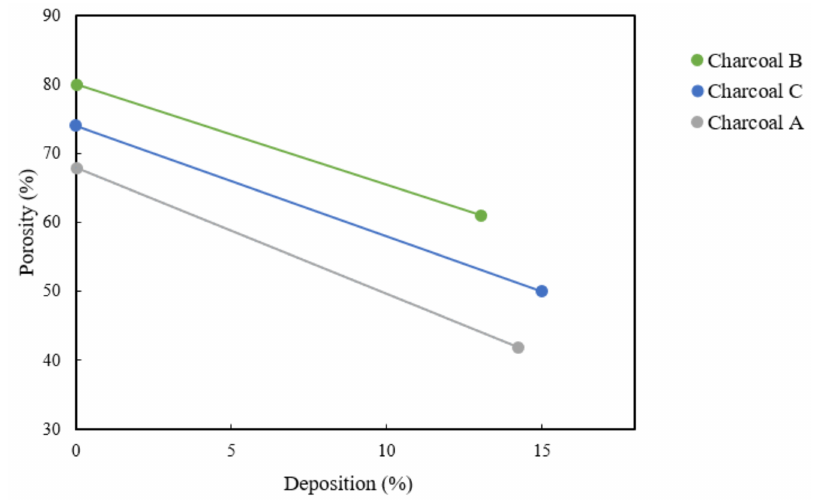
Figure 6. Porosity of charcoals before and after